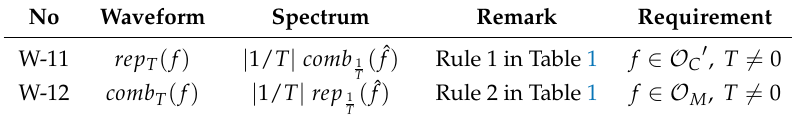
Table 2. Woodward’s Rules 11 & 12 in [2], p. 28, endowed with validity